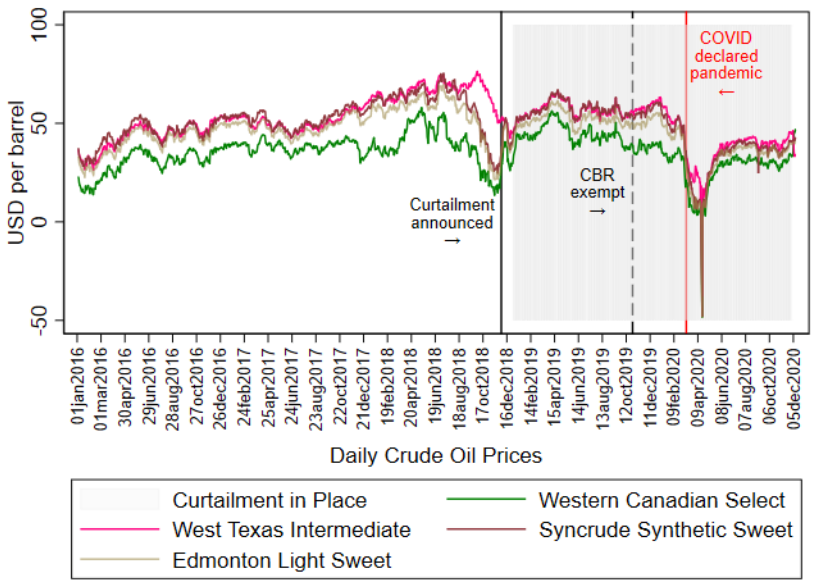
Figure 1. Daily Crude Oil Prices, 2016–2020 [8,9]. Western Canadian Select (WCS) is a key bench- mark for Alberta heavy oil production, Edmonton Light Sweet is a benchmark for Alberta light oil production, and Syncrude Synthetic Sweet is a benchmark for Alberta synthetic crude oil (derived from the oil sands). “CBR” is crude by rail, which became exempt from curtailment on 28 October 2019. See Figure 2 for the full